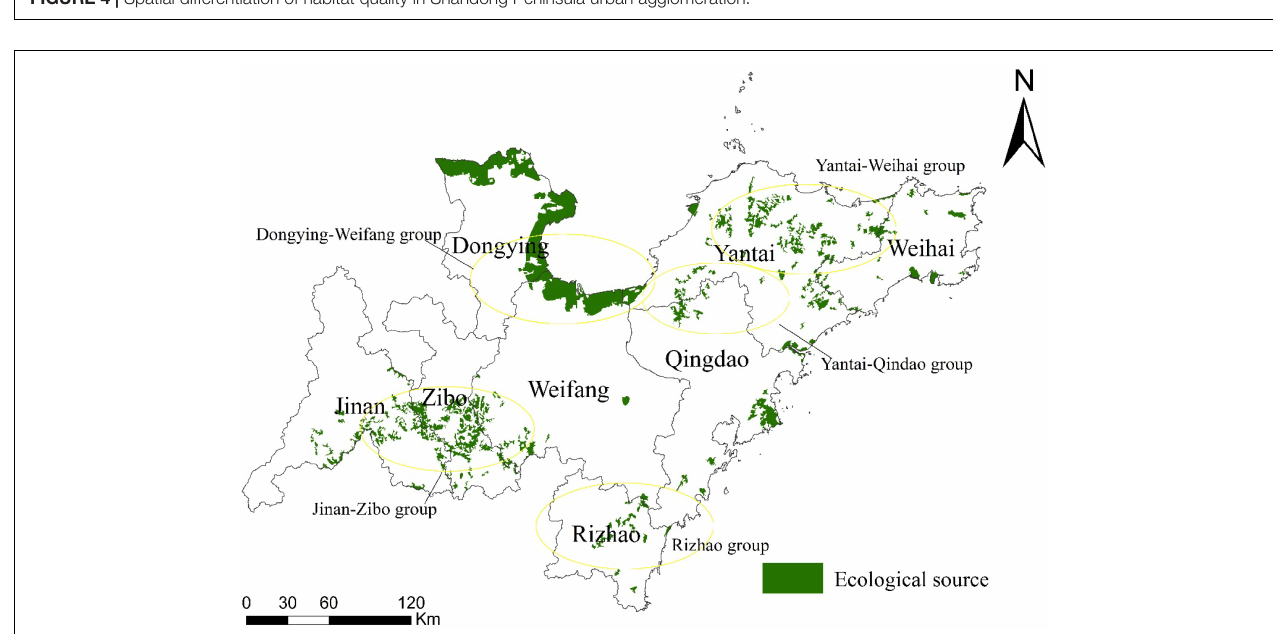
FIGURE 4 | Spatial differentiation of habitat quality in Shandong Peninsula urban agglomeration.